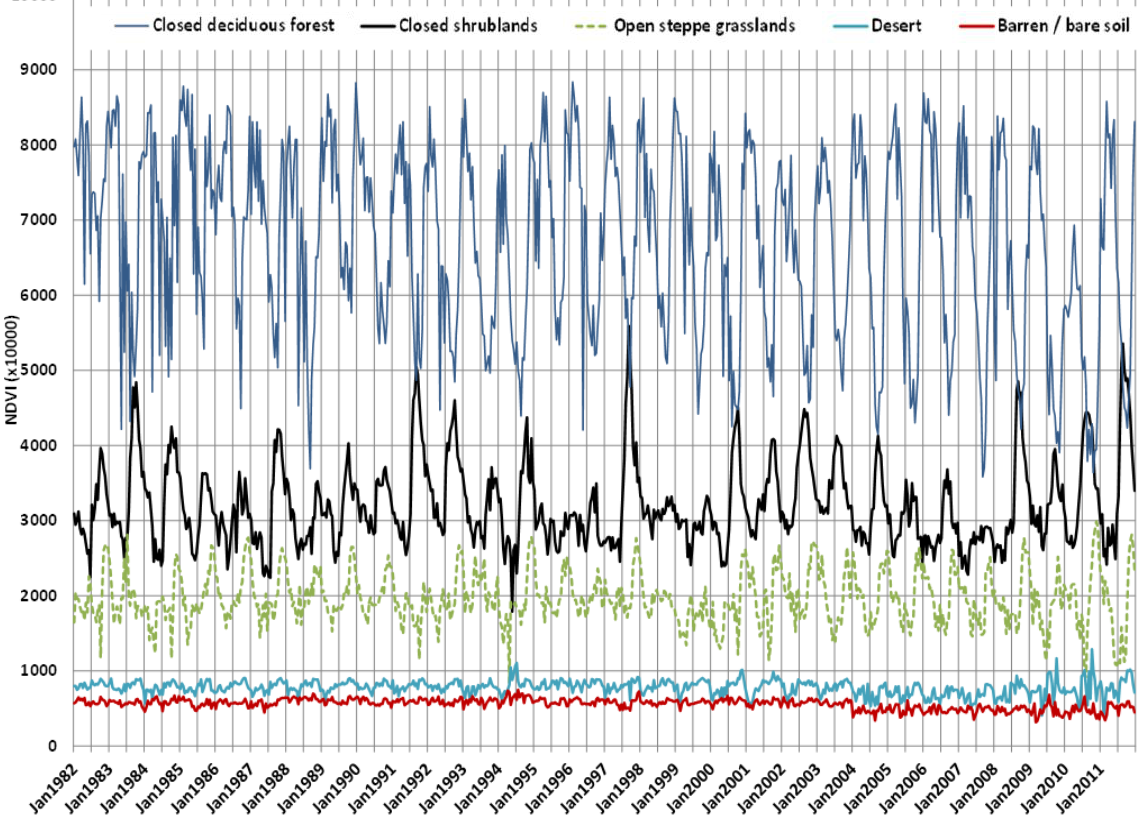
Figure 3. Interannual variability in phenological trajectories for some of the sample points. The closed deciduous forest point represents a decrease in NDVI of more than 5% while the barren point represents a decrease of less than 2%, significant at p ≤